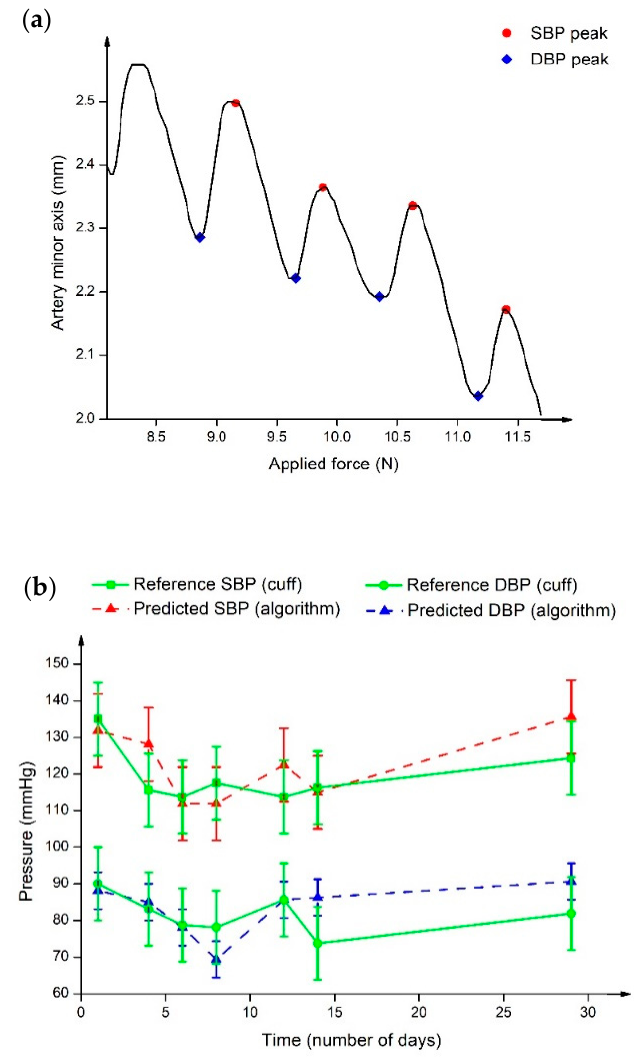
Figure 6. ( a ) Arterial tissue displacements against applied force graph. The arterial size changes showing internal BP pulse upon application of external pressure. Different marker colours define SBP (red) and DBP (blue) locations at the peak and trough of pressure waveform. ( b ) BP sweep of hypertensive subjects in one month, where the green line represents the reference BP from the cuff sphygmomanometer, and the red and blue dashed lines show the predicted SBP and DBP, respec- tively.